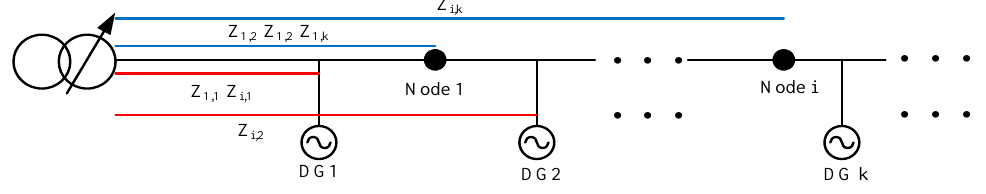
Figure 1. The impedance by location of distributed generations (DGs) and nodes.